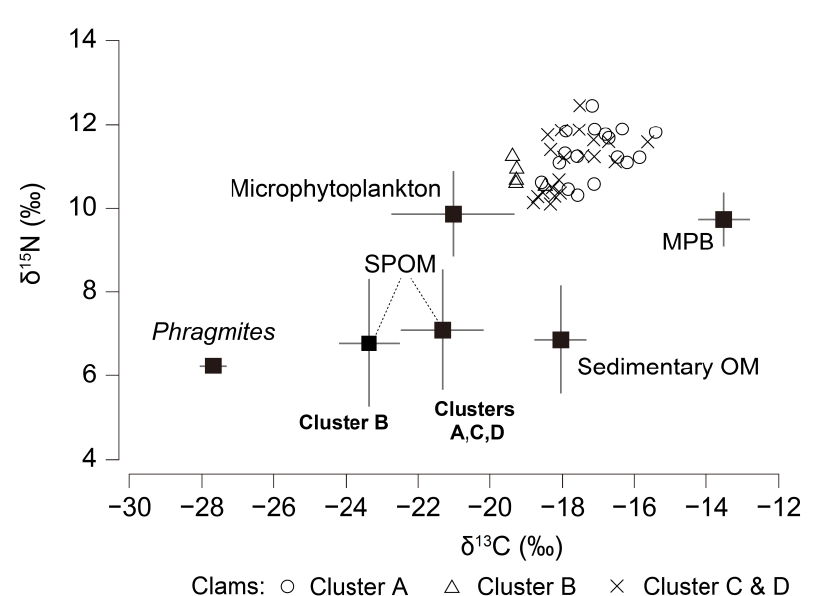
Figure 7. Bi-plots of the δ 13 C and δ 15 N values of a consumer, the ark shell A. kagoshimensis , and its potential food sources, i.e., microphytobenthos (MPB), microphytoplankton, suspended particulate organic matter (SPOM), Phragmites australis , and sedimentary organic matter (sedimentary OM). The circles, triangles, and crosses represent the ark shell values of clusters A, B, and C–D, respec- tively.